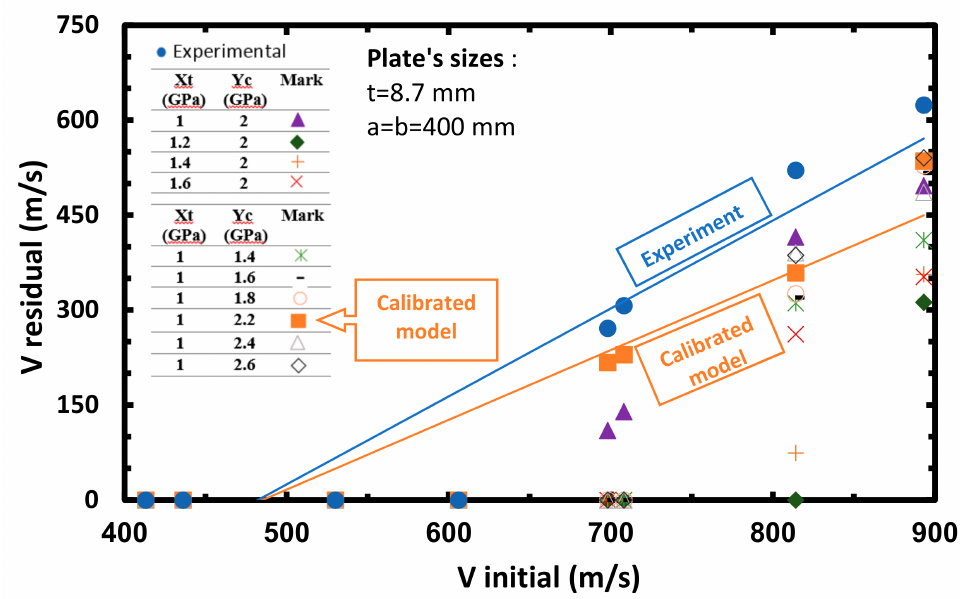
Figure 10. Projectile’s residual velocity vs. initial velocity at varying Xt and Yc.